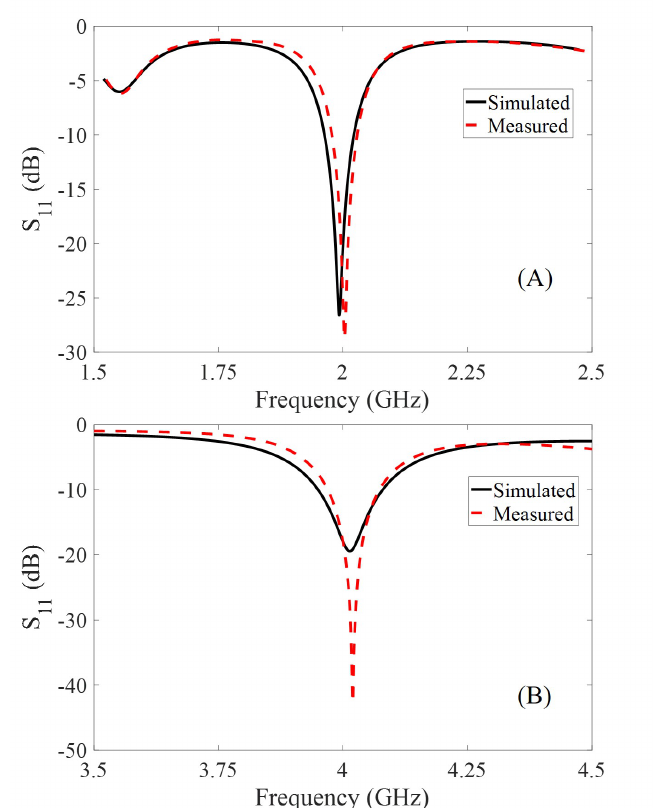
Figure 8. Simulated and measured frequency response; ( A ) Fundamental (2 GHz) and ( B ) Harmonic antenna (4